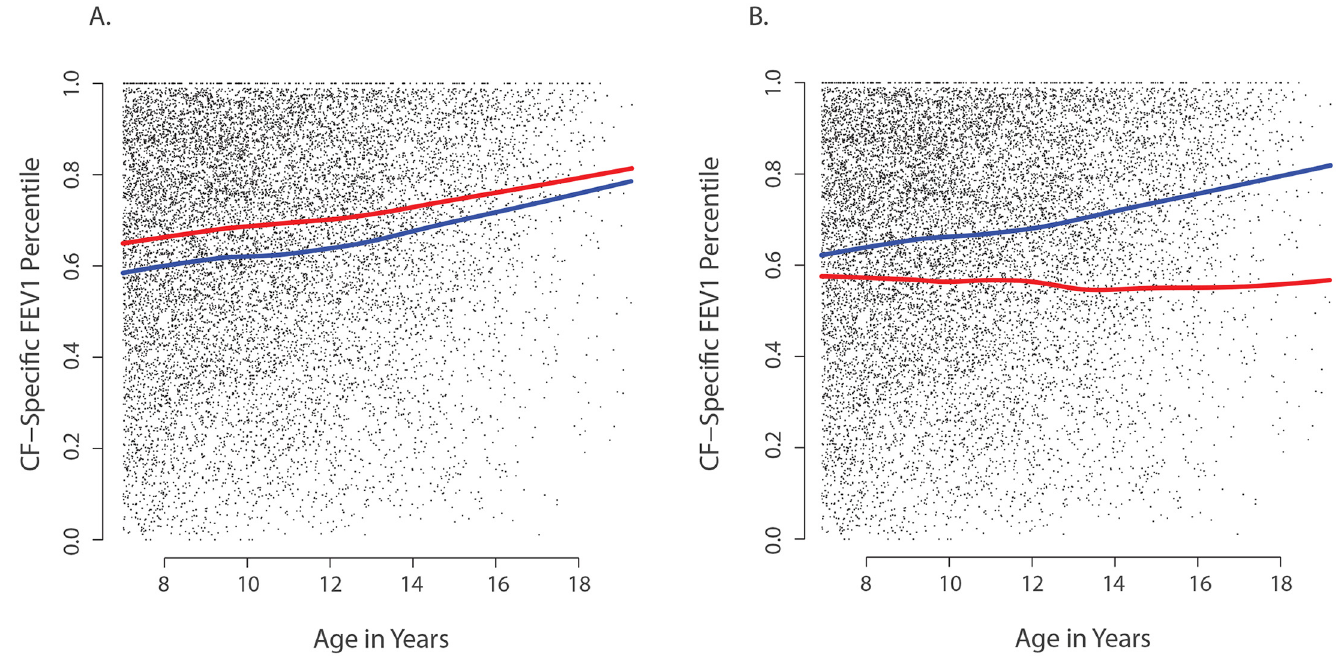
Fig 3. Association of CAV2 and TMC6 variants with lung function. Each small dot in each panel represents one CF-specific FEV1 percentile value in the data set (percentiles are age- and sex-adjusted); and each individual has an average of 3.5 percentile values per year in the data set. ( A ) Mean CF-specific FEV1 percentile by age for 289 EPIC validation individuals with (red) and 283 without at least one CAV2 rs8940 derived allele (blue). FEV1 was an average of 5.5 percentile points higher among individuals with the rs8940 derived allele (p = 0.001). ( B ) Mean CF-specific FEV1 percentile by age for 59 EPIC validation individuals with (red) and 513 without at least one TMC6 rs34712518 derived allele (blue). FEV1 was an average of 8.0 percentile points lower among individuals with the rs34712518 derived allele (p = 0.01). The apparent age interaction in the diagram (growing distance between lines) was not significant here, though power is limited by the lower numbers of observations at older